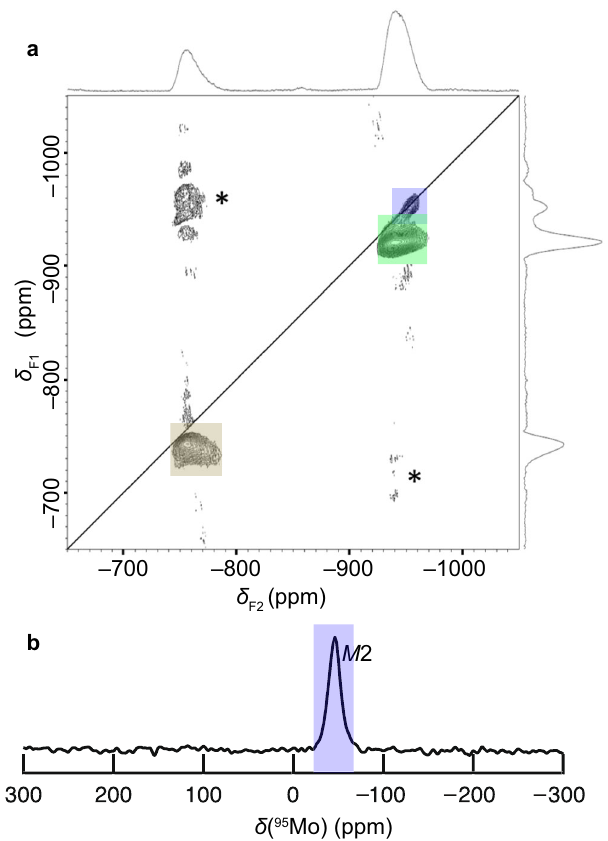
Fig. 3 | Solid-state NMR spectra of Ba 7 Nb 4 MoO 20 ·0.15 H 2 O, showing the site assignment and Mo order. a 2D 93 Nb 3QMAS NMR spectrum and b 1D 95 Mo MAS